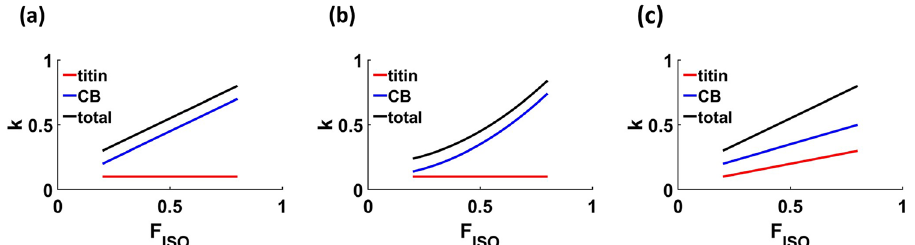
Figure 1. Theoretical relationships between relative muscle stiffness ( k m ) and relative isometric force ( F ISO ). Total muscle stiffness (black) is estimated as the sum of titin stiffness (red) and cross-bridge (CB) stiffness (blue). ( a ) If the proportion of weakly- to strongly-bound cross bridges is independent of F ISO and titin stiffness is constant, then the relationship between k m and F ISO will be linear. ( b ) If titin stiffness is constant, but the proportion of weakly- to strongly-bound cross bridges depends non-linearly on F ISO , then the total stiffness will also increase non-linearly with F ISO . ( c ) If both titin stiffness and the proportion of weakly- to strongly-bound cross bridges increase linearly with F ISO , then the total stiffness should also increase linearly with F ISO